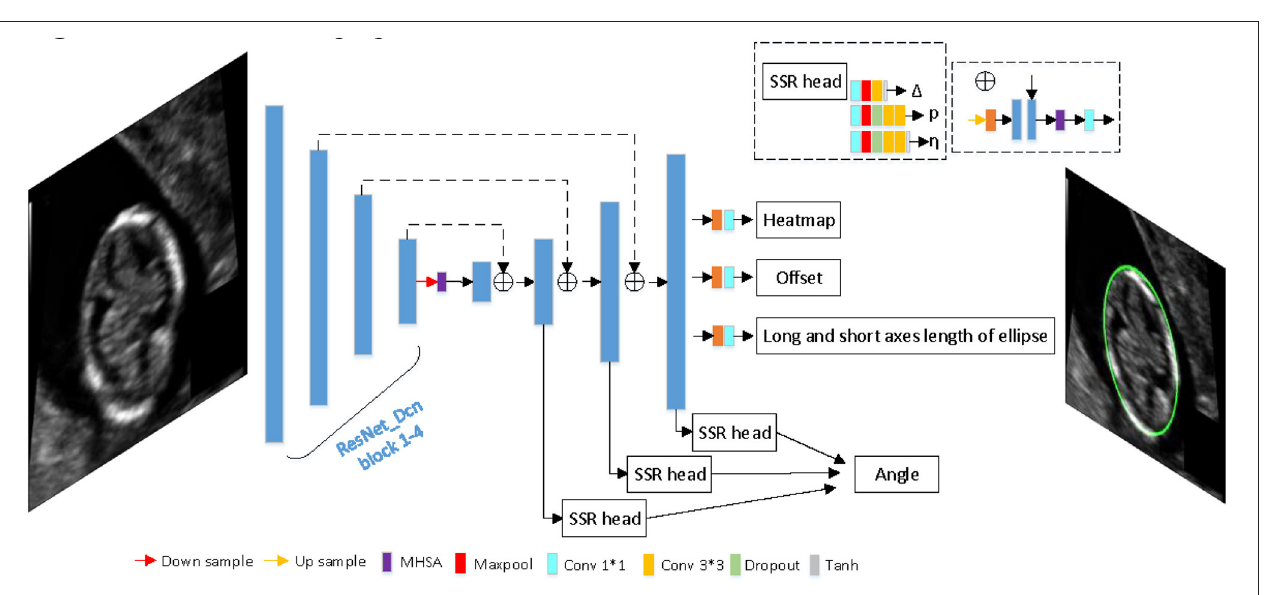
FIGURE 2 | The architecture of proposed